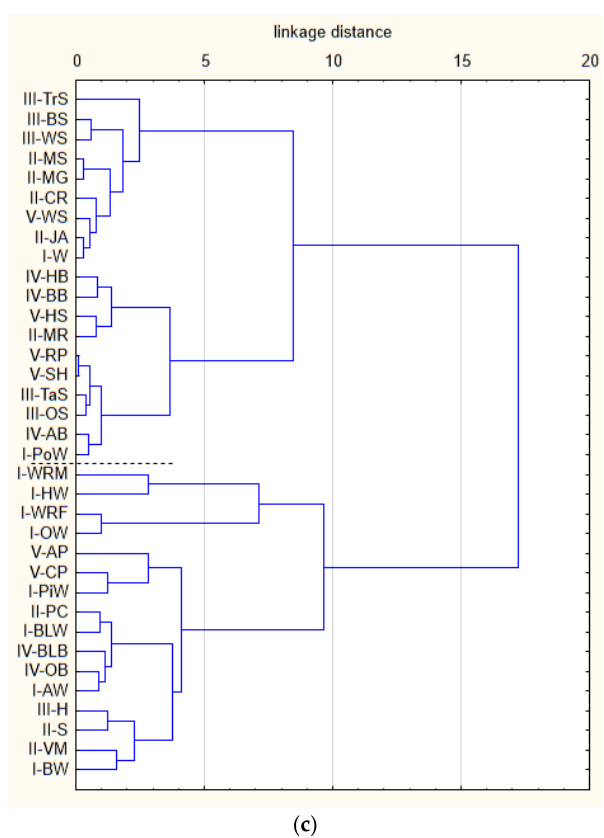
Figure 1. Dendrogram with the division of raw materials due to the contents of ( a ) P, K, Ca, S; ( b ), Cu, Fe, Mn, Zn; and ( c ) As, Pb, Ni, Cr.